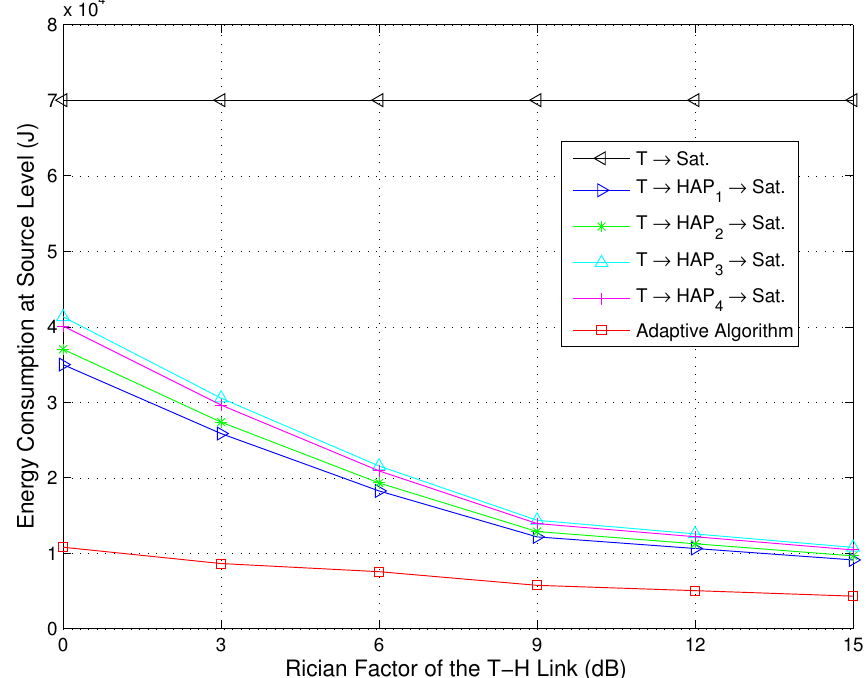
Figure 7. Energy consumption for the direct path, relay paths and adaptive path selection versus the Rician factor at the source level ( N